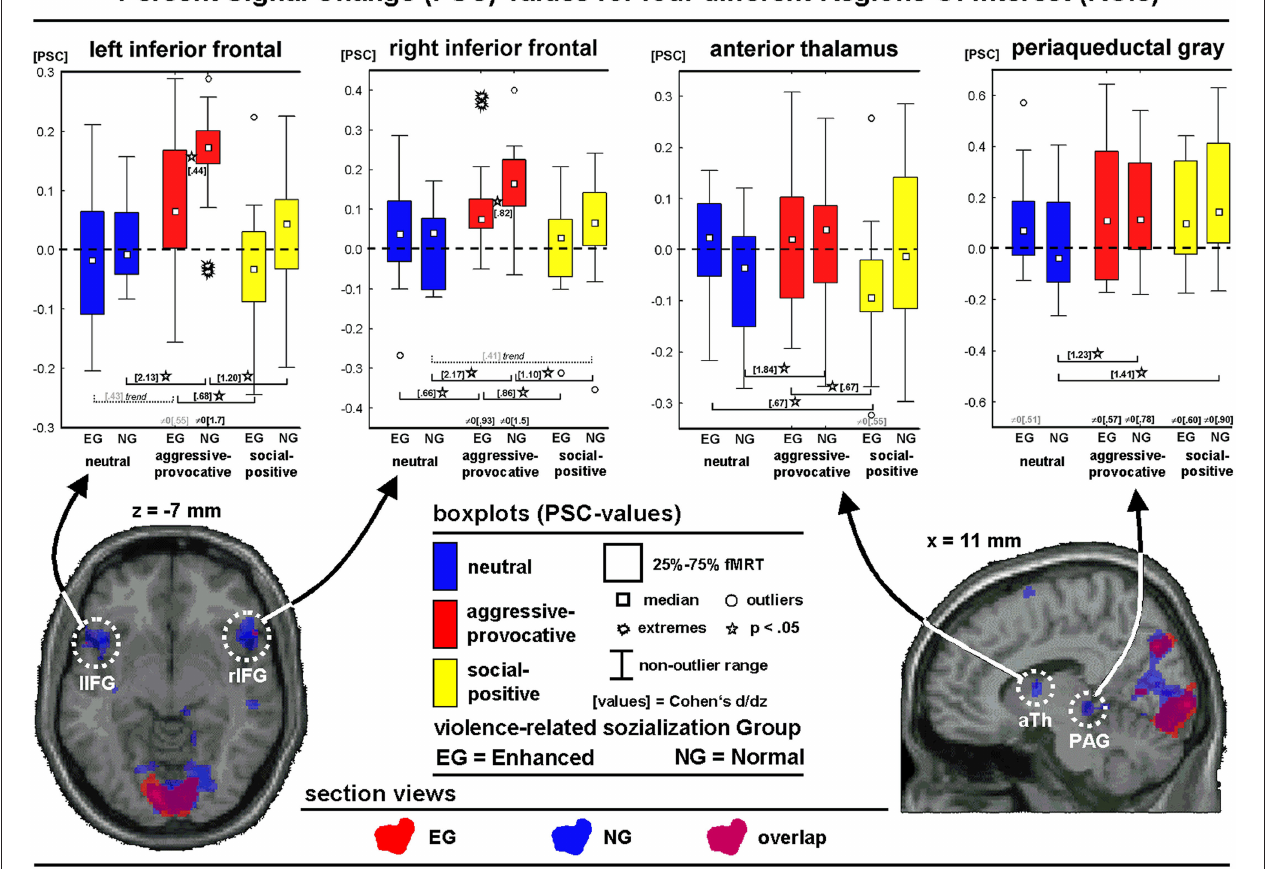
FIGURE 6 | Regions of interest analyses showing section views and box-plots of four regions of interest (ROIs) illustrating the distribution of the percent signal change (PSC) values (see text for more details) of the different emotional categories for the initial phase (PHASE I) of the interactions: Neutral, social-aggressive-provocative, and